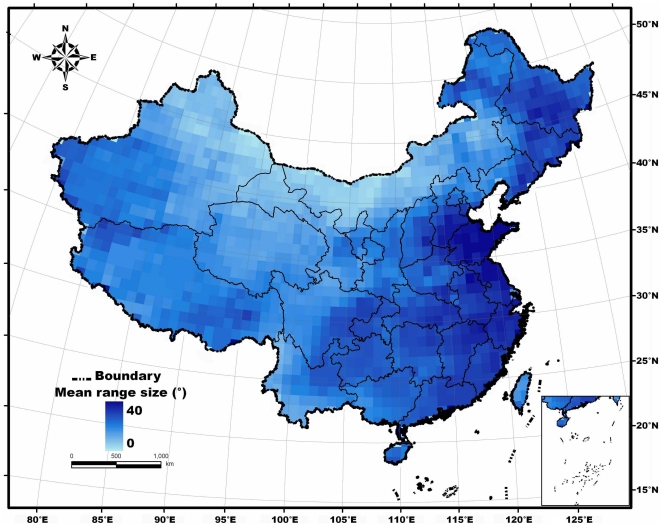
Geographical pattern of mean latitudinal range size of terrestrial mammals in China, resolved to 100 km×100 km.The color gradient represents the mean latitudinal range extent in each grid cell.